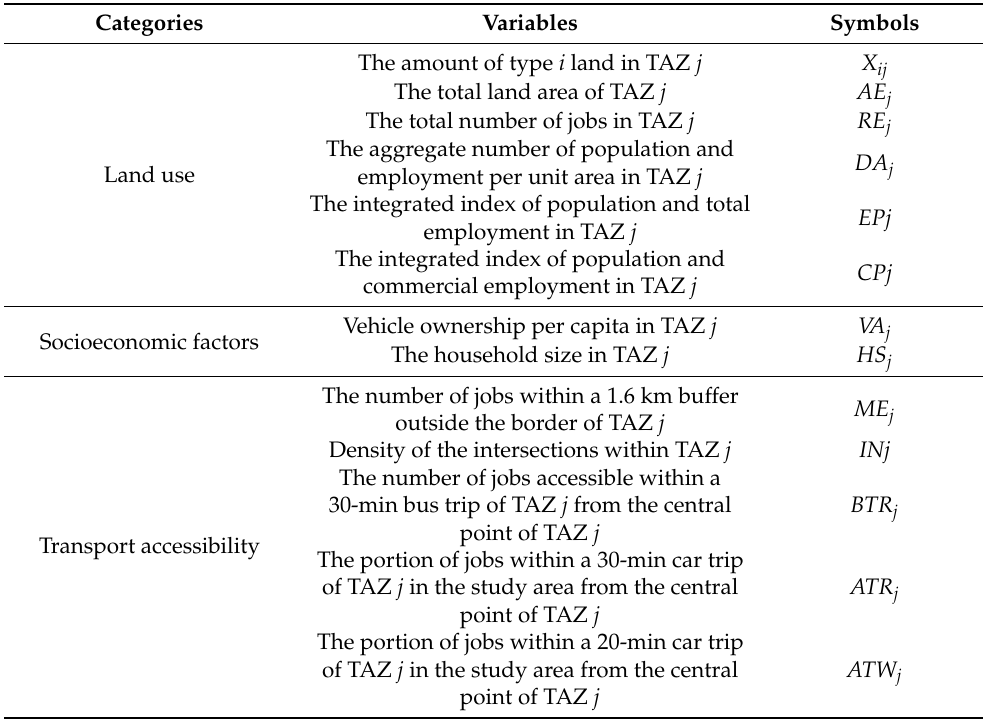
Table 1. Variables of the input elements in the mixed-use development